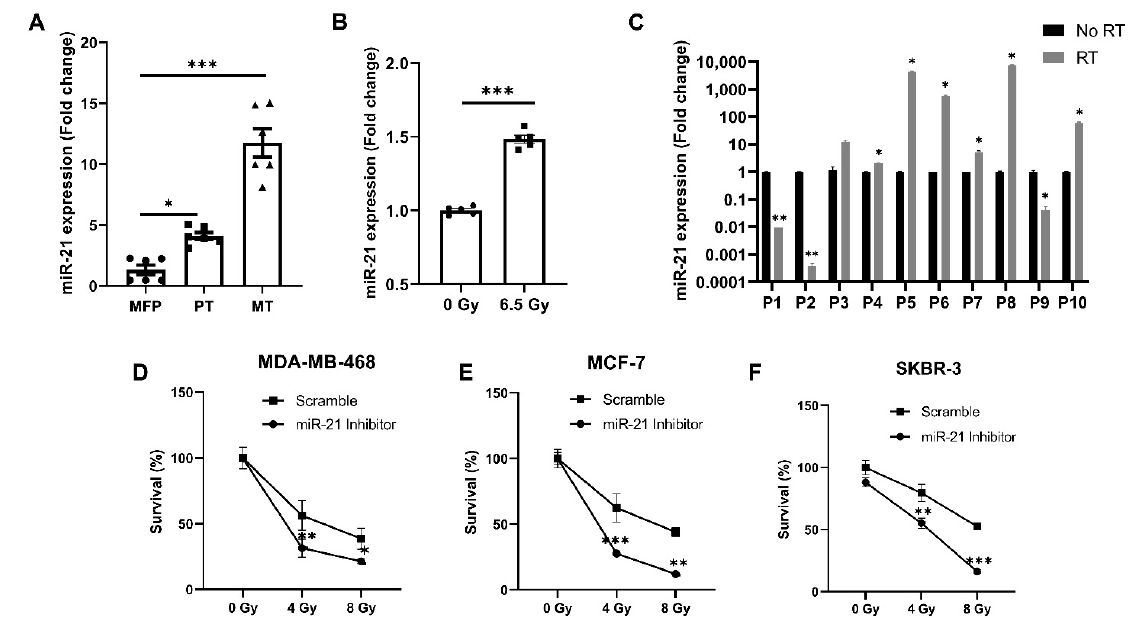
Figure 1. Stress-activated miR-21 plays a critical role in breast cancer growth and metastases. ( A ) miR-21 expression was increased as the breast cancer progressed. Basal levels of miR-21 were seen in the normal fat pad, the orthotopic primary tumor showed increased expression of miR-21, and the maximum increase in miR-21 was seen in lung metastases ( n = 2 mice/group; ● —Individual replicates for normal mammary fat pad (MFP), ▪ —Individual replicates of primary tumor (PT) ▲ —Individual replicates of Metastases (MT). ( B ) Radiation-caused stress induced increases in miR-21 expression in the primary tumor ( n = 2 mice/group; ● —Individual replicates for primary tumor without radiation, ▪ —Individual replicates of primary tumor irradiated with dose 6.5 Gy). ( C ) miR-21 expression was increased in human serum post-radiation ( n = 10). ( D ) Knockdown of miR-21 with a specific inhibitor sensitized MDA-MB-468, MCF-7 ( E ), and SKBR3 ( F ) cells to increasing doses of radiation over a total treatment period of 72 h ( n = 3/group). For ( A – C ), mean ± SEM with ***, ** are significantly different with p < 0.001 or <0.01 as determined by one-way ANOVA or student’s t -test. For ( D – F ), mean ± SD with ***, **, * are significantly different with p < 0.001 or < 0.01 or 0.05 as determined by one-way ANOVA or student’s t - test.